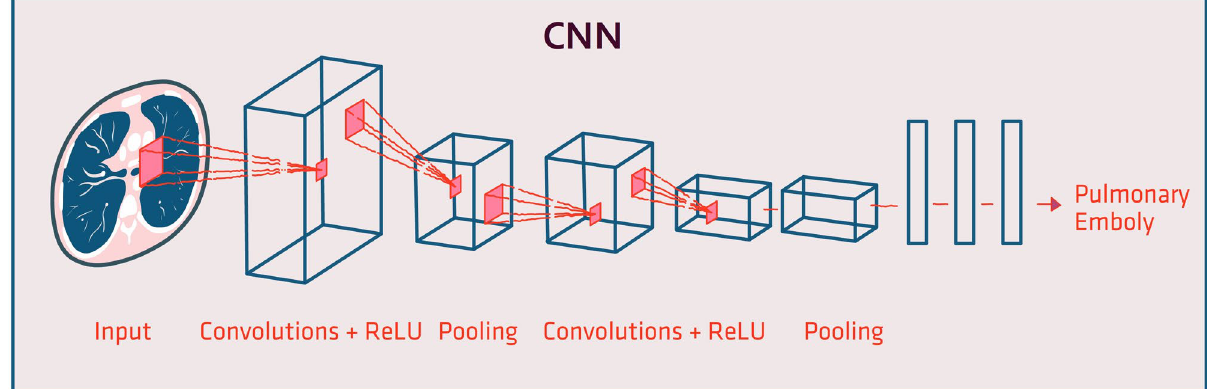
Figure 3. The architecture of Convolutional Neural Network (CNN). CNNs are networks specifically designed to process images. Many small filters compose each CNN layer. A filter is a small matrix of weights that is repeatedly applied to the image pixels. By sharing the filter across the image, repeating patterns are recognized. CNNs are ideal for image analysis since images are composed of repeating patterns. The shallow layers of the CNN recognize low-level patterns. The deeper layers gain a high-level understanding of the